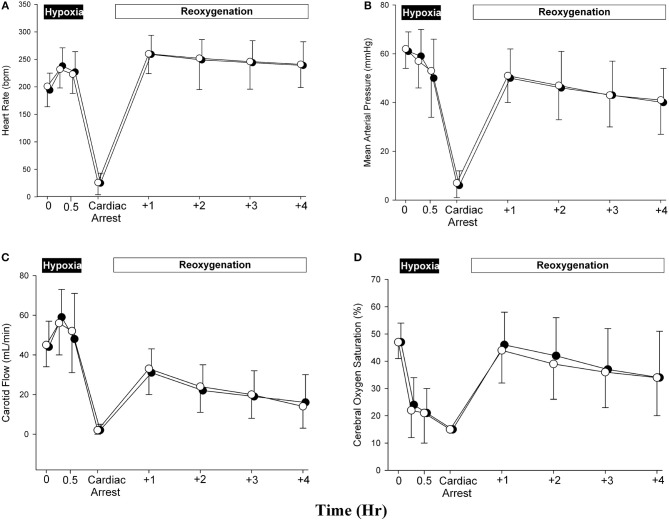
Changes in (A) heart rate [beats per minute (bpm)], (B) mean arterial blood pressure (mmHg), (C) carotid blood flow (mL/min), and (D) cerebral oxygen saturation (%) during hypoxia, asphyxia, and post-resuscitation (solid circle represents male and open circle represents female).